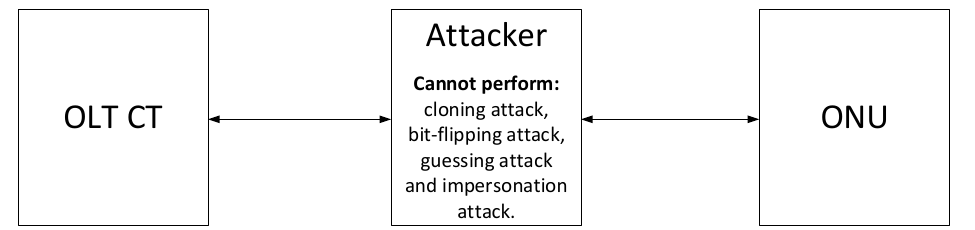
Figure 4. Unfeasible attacks on optical network unit (ONU) and optical line termination (OLT) channel termination (CT) in our security